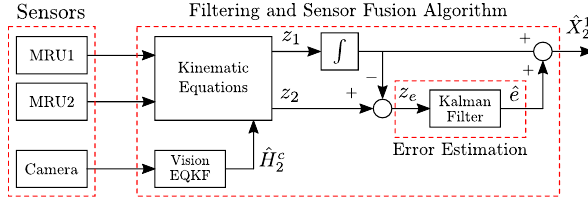
Figure 3: Illustration of the proposed sensor fusion al- gorithm combining the camera and the MRU measurements.